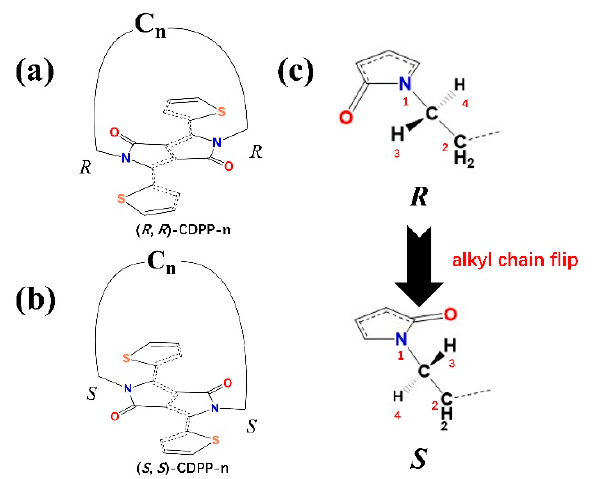
Figure 2. Molecular structure of ( R , R )-CDPP ( a ); and ( S , S )-CDPP ( b ); ( c ) The chiral center of ( a , b ), ( a ) can be changed into ( b ) through flipping the alkyl chain.